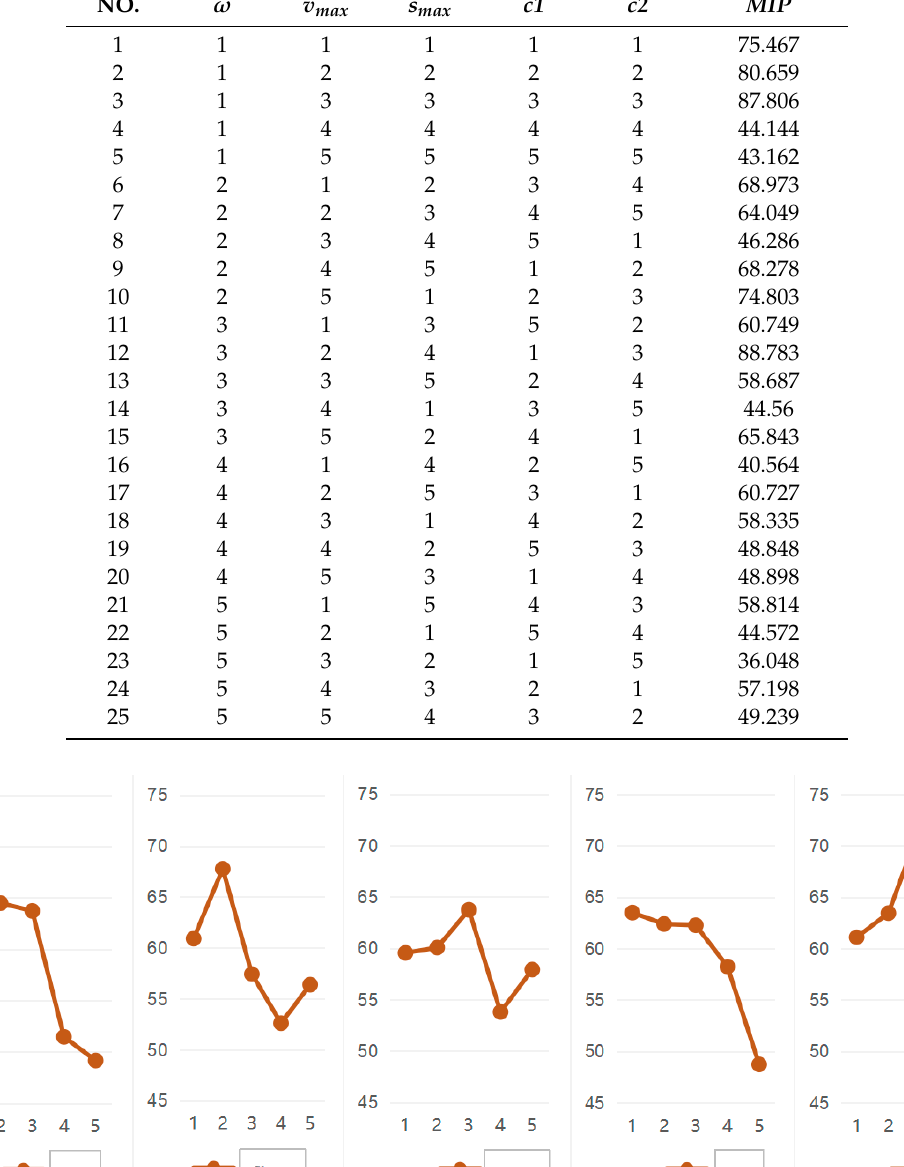
Table A6. PSO algorithm parameters orthogonal experiment results.